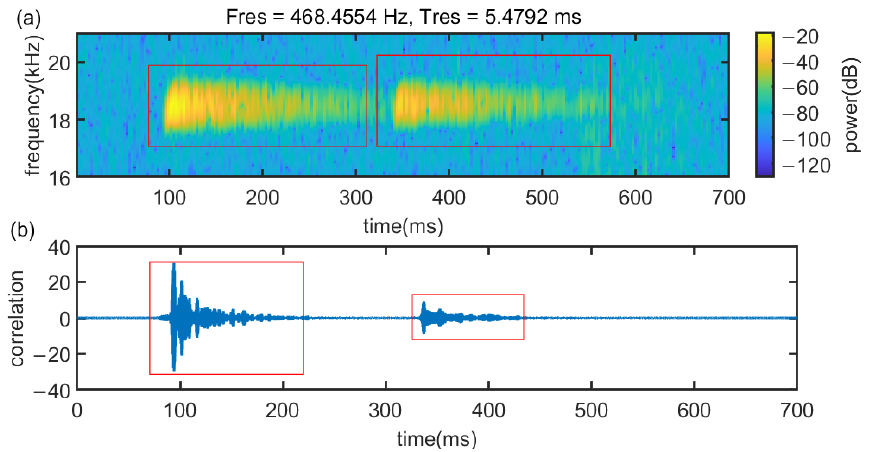
Figure 25. Signal propagation characteristics in case 2. ( a ) Signal spectrogram and ( b ) cross-correlation results.